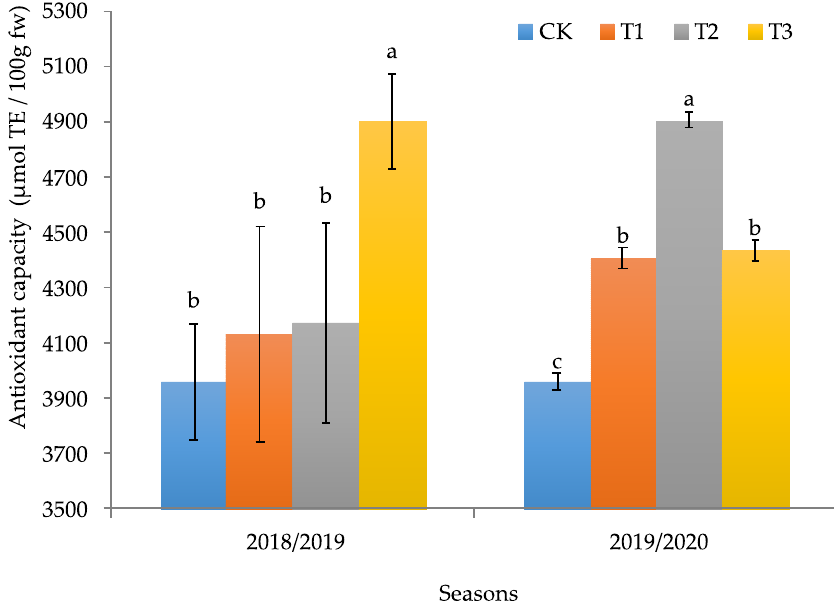
Figure 5. Effect of different doses of compost on the antioxidant capacity of the Calafate fruit ( Ber ‐